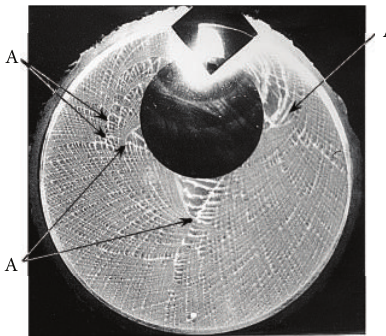
Figure 11: A photo of DW “rotation” around of a cylindrical surface. A: Centers of DW